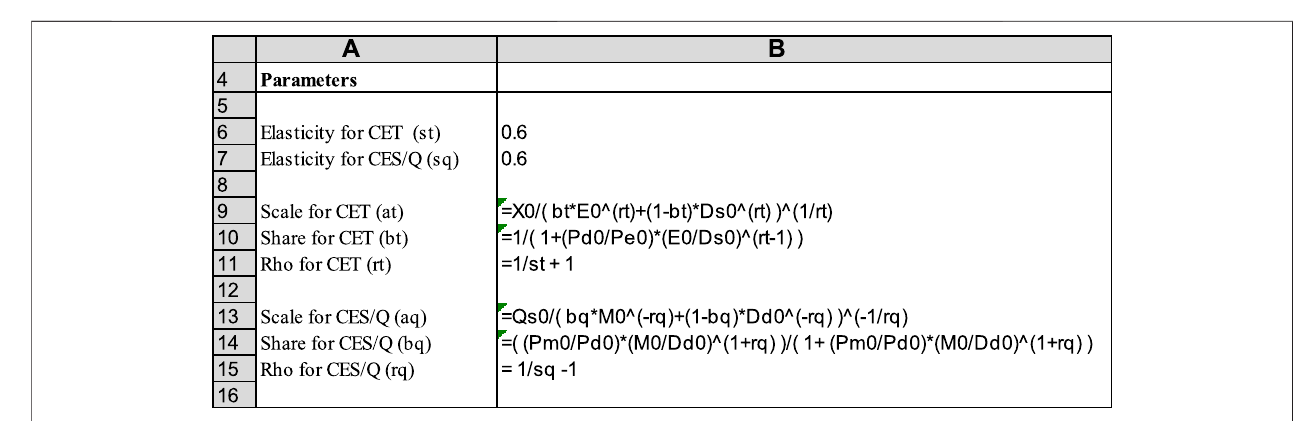
FIGURE 1 | Parameter calibration of the “ 1-2-3 ”